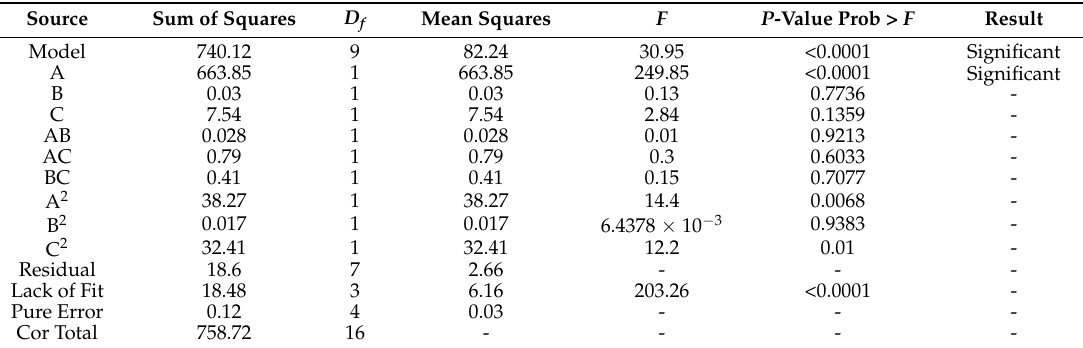
Table 5. Variance analysis of regression models.